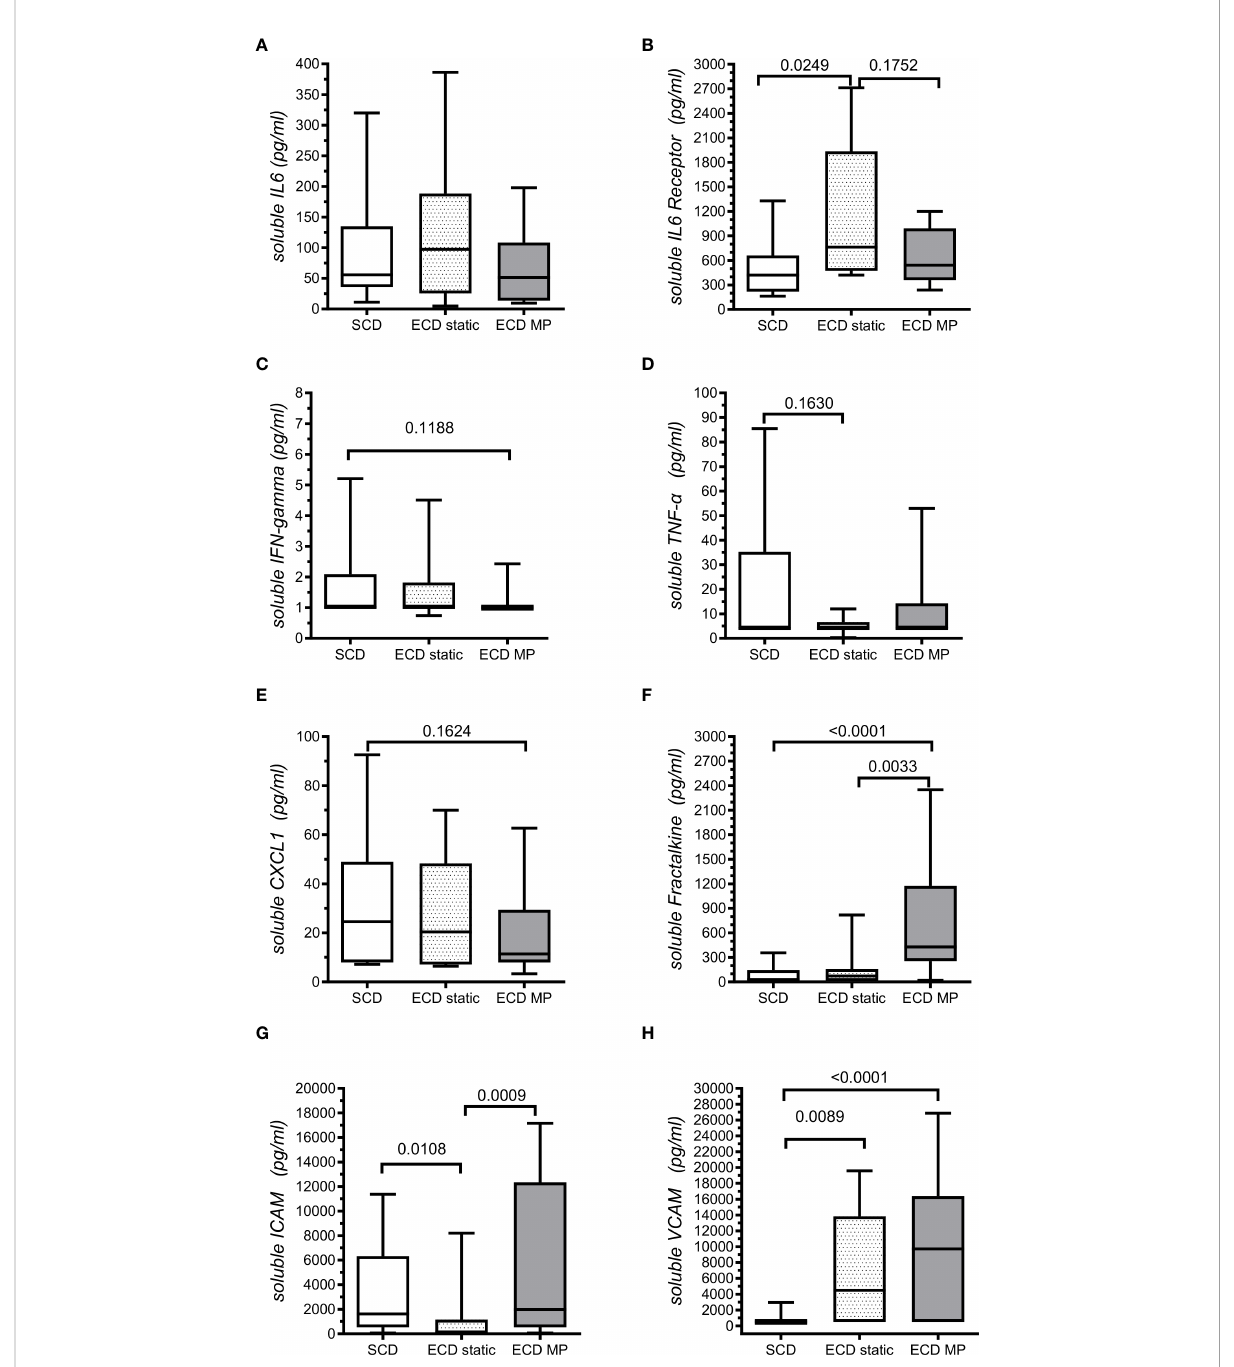
FIGURE 2 Quantitative analysis of soluble in fl ammatory biomarker levels in transplant preservation fl uids. Levels of soluble iammatory markers were analyzed by ELISA in preservation fl uids from SCD transplants (Standard criteria donors n = 27, all conserved in static conditions) and from ECD transplant (extended criteria donorsn n=47) further classi fi ed as a group of transplants conserved in static conditions (ECD static: n = 8) and a group of transplants conserved by machine Perfusion (ECD MP, n = 39). Different panels of soluble markers evaluated are represented : (A) Soluble IL6, (B) Soluble IL6 receptor, (C) Soluble IFN-gamma, (D) Soluble TNF-alpha, (E) Soluble CXCL1, (F) Soluble Fractalkine, (G) Soluble ICAM, (H) soluble VCAM. Signi fi cant p values ( p <.05) or trends for signi fi cance were ( p < .2) resulting from non- parametric Mann-Whitney test comparison of evaluated soluble biomarkers median levels are